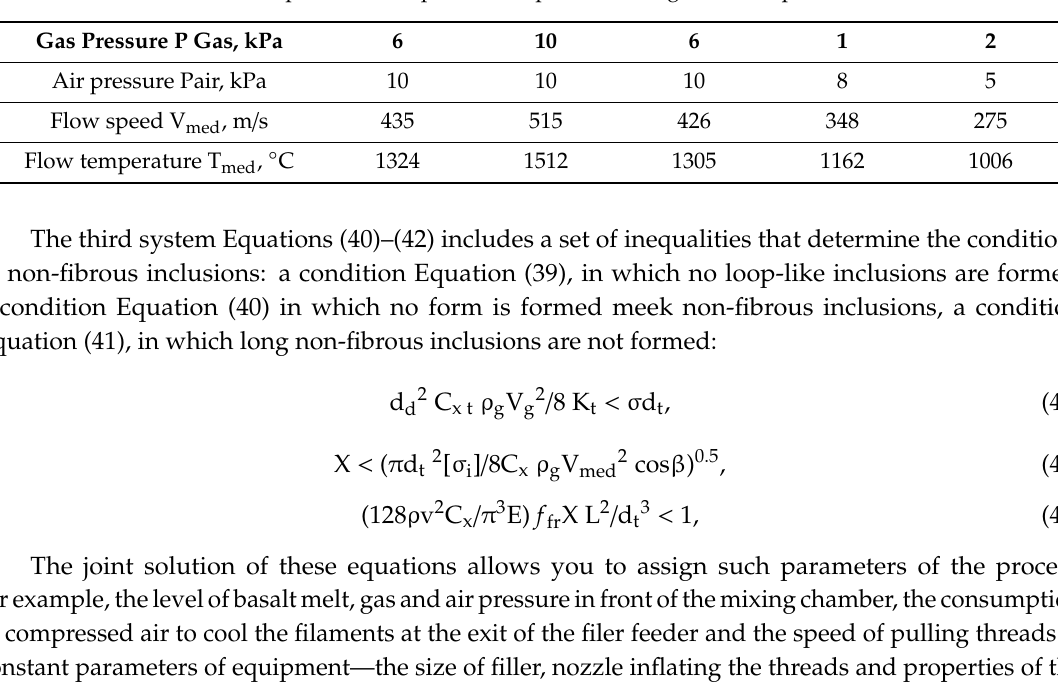
Table 2. Speed and temperature dependence on gas and air